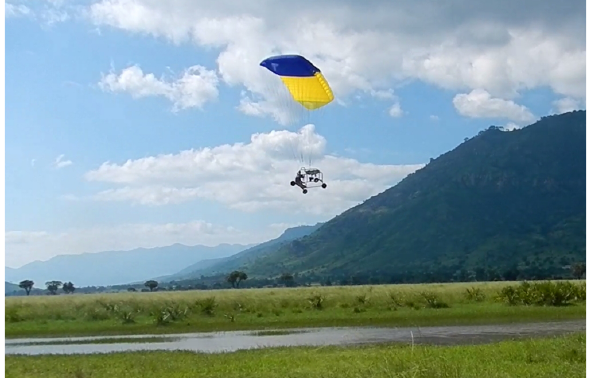
Figure 1. SUSI 62 in operation, Malinda Wetland May 2012 When losing contact with the remote control, the engine stops automatically and the servos bring the parachute into a landing position, so the UAS turns in the direction of the wind and comes down, with a sinking speed of around 2,5 m/s. The total system only requires three servos, thus, reducing the risk of malfunction. The electronics on board are supplied by a 6000 mAh FePo rechargeable battery pack which lasts between 4 -6 hours. A spare 1800 mAh battery pack automatically activates if the main battery pack is flat or damaged. Due to legal issues the strength of the radio transmission (2,4 GHz) is limited with a range of approximately 2